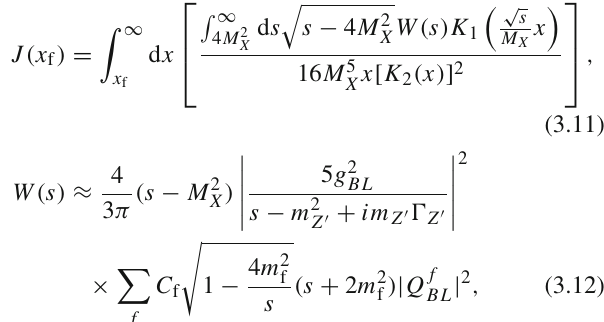
(cid:17) ∞ (cid:13) σv (cid:14) ) is given by rel d x x f x 2